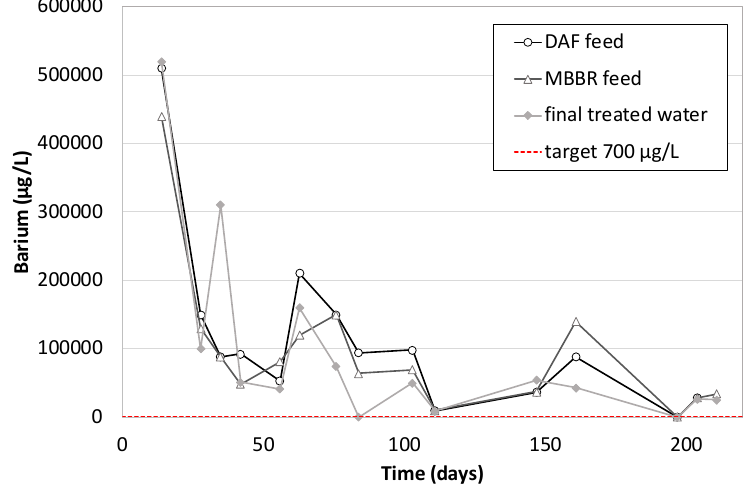
Figure 15. Barium concentration along the pilot unit versus time of operation.